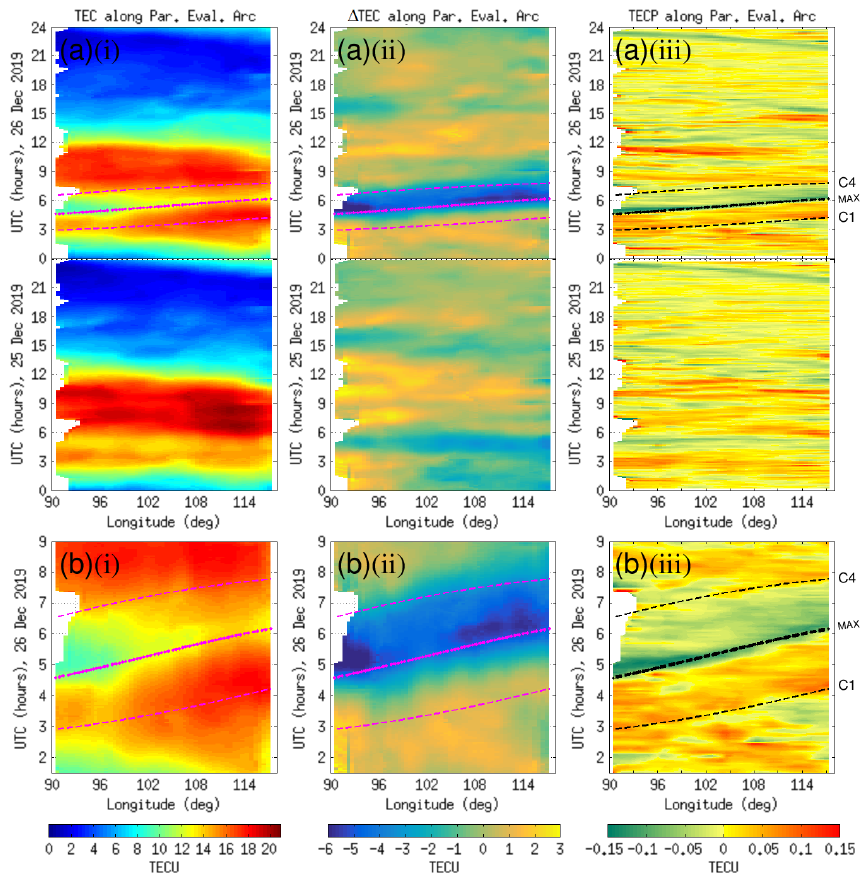
Figure 12. Color-map plots of GPS TEC, (cid:49) TEC, and TECP values as a function of time and longitude along the parallel evaluation arc (a) within a 48h time interval on 25 and 26 December 2019 and (b) within a magnified time interval around the solar eclipse on 26 December 2019. The start and end times of the eclipse (C1 and C4) as well as the moment of maximum eclipse are indicated by dashed and dotted curves on the